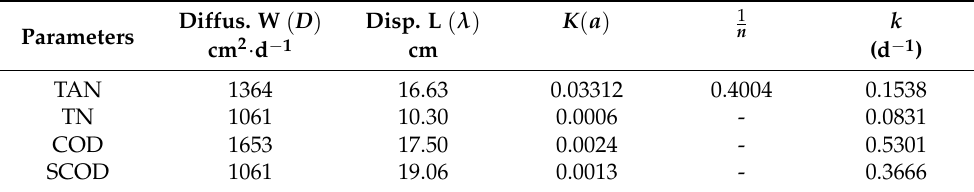
Table 5. Corrected characteristic parameters for solute migration in